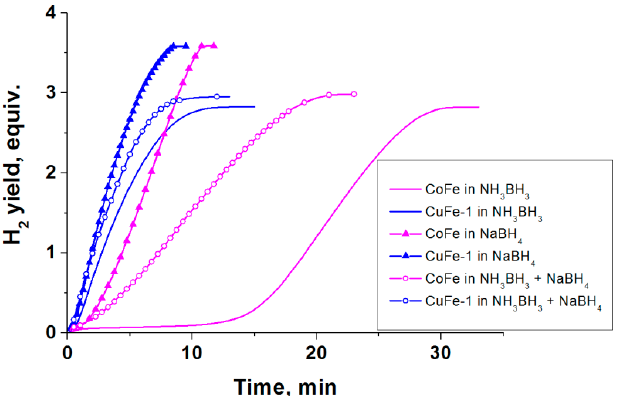
Figure 5. The effect of reductive ability of hydride medium on the hydrogen generation during catalytic hydrolysis of solutions of NH 3 BH 3 (0.123 M), NaBH 4 (0.123 M) and NH 3 BH 3 (0.105 M) with NaBH 4 (0.018 M) over copper and cobalt ferrites at 40 ° C.